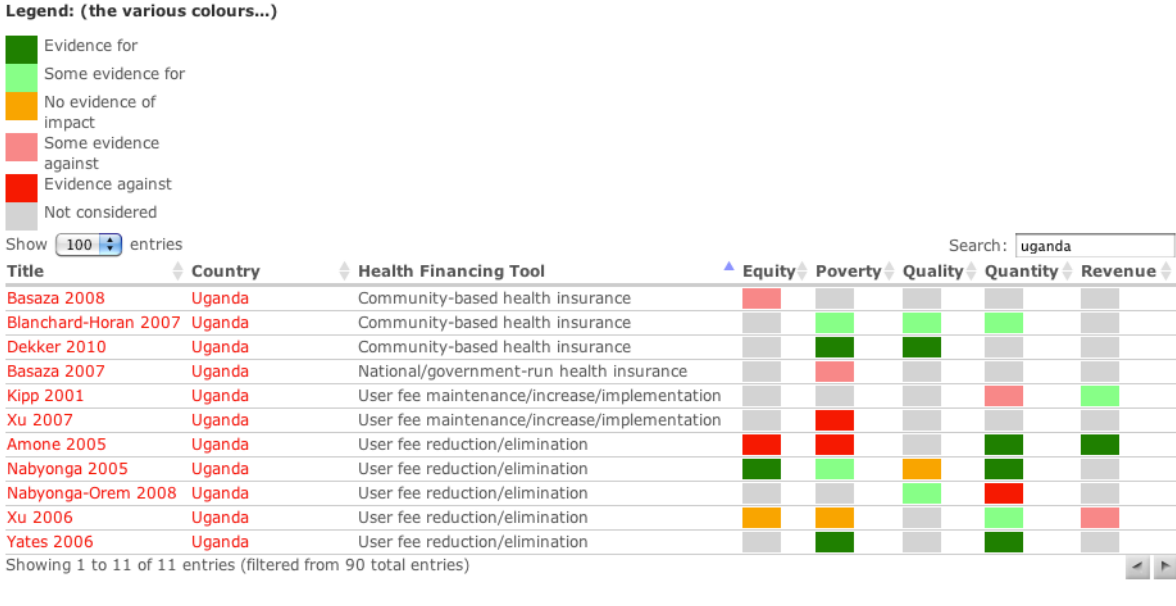
Figure 5. Screenshot of the list of studies showing summary of impact. Any search term could be used (here: Uganda), or the gray arrows at the top of each column used to sort the entire list. The text in red represents links to the extended information on the given studies and